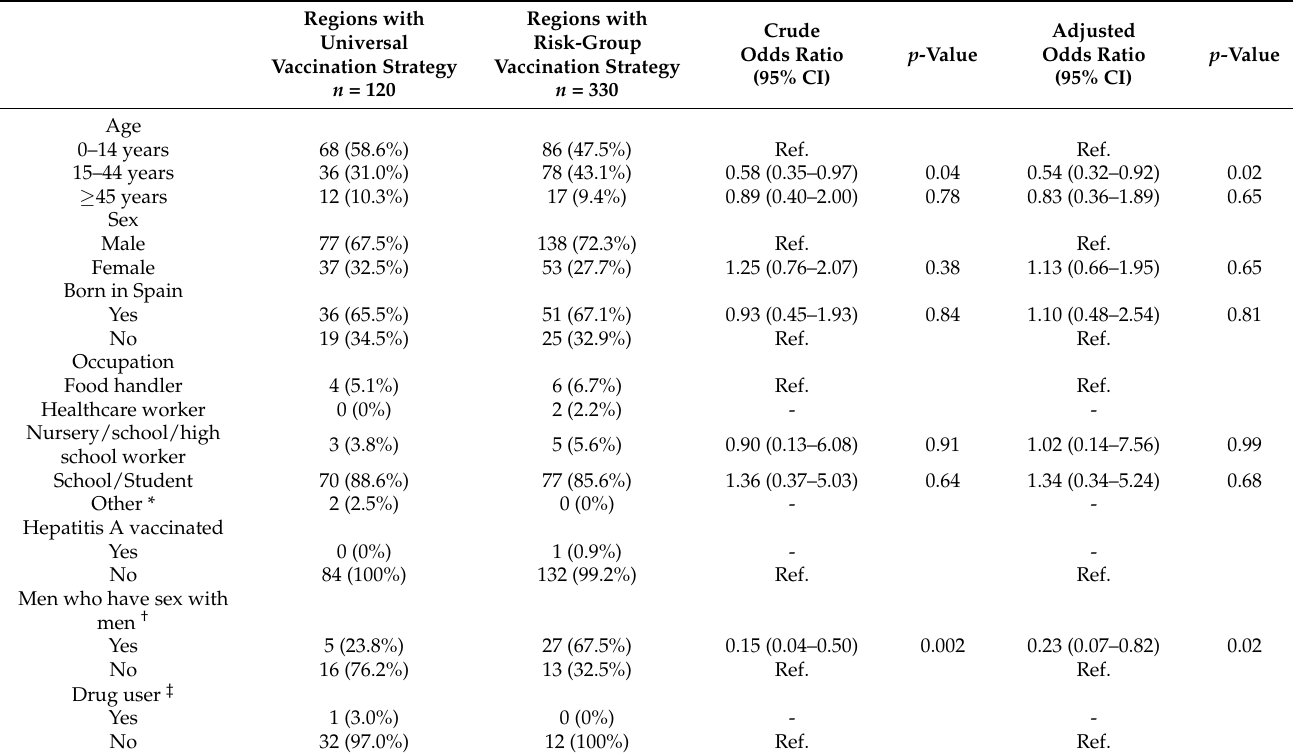
Table 4. Characteristics of the first case in hepatitis A outbreaks in regions with different vaccination strategies. Spain,